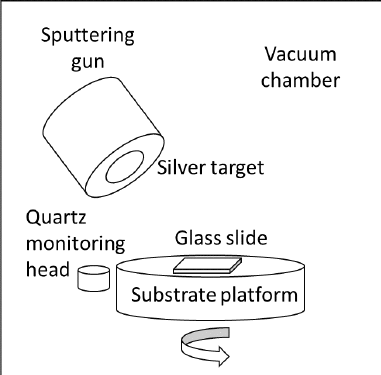
Figure 1. The schematic diagram of the sputtering system.